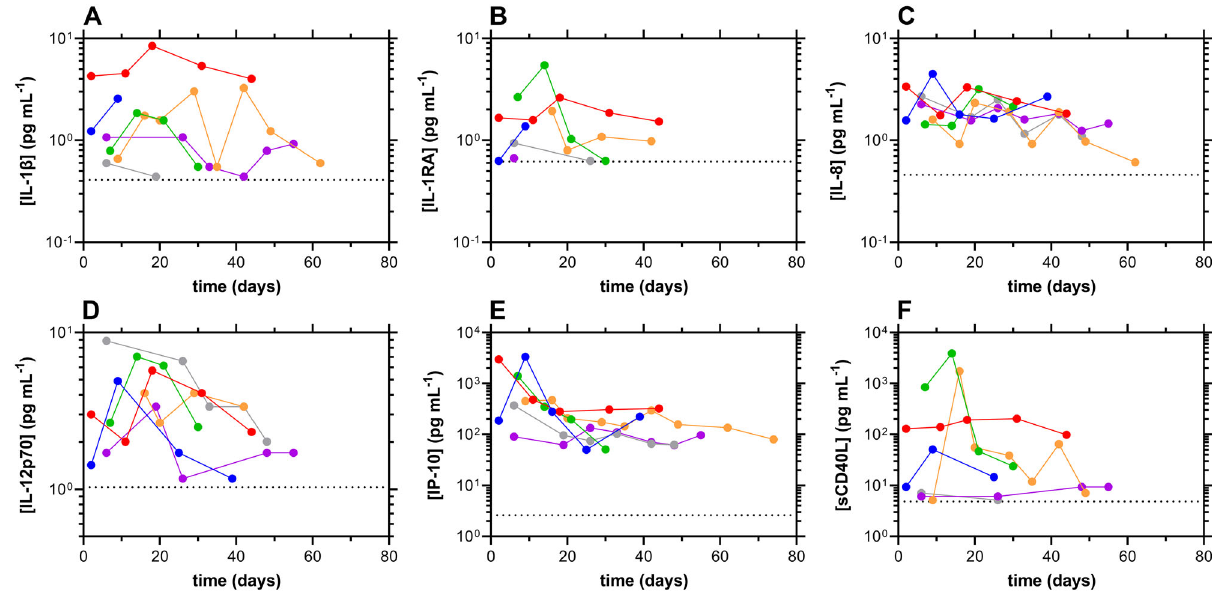
Fig. 5 Cytokine/chemokine concentration-time pro fi les for participants testing positive nasally for SARS-CoV-2 RNA, normalized temporally to the fi rst day of positivity by RT-qPCR. Not all subjects testing positive participated in the blood collection portion of the study. The dotted line represents the assay lower limit of quantitation; blue, subject 2; red, subject 21; green, subject 38; orange, subject 48; magenta, subject 83; gray, subject 84. A IL-1 β ; B IL-1RA; C IL-8; D IL-12 p70; E IP-10; F sCD40L.